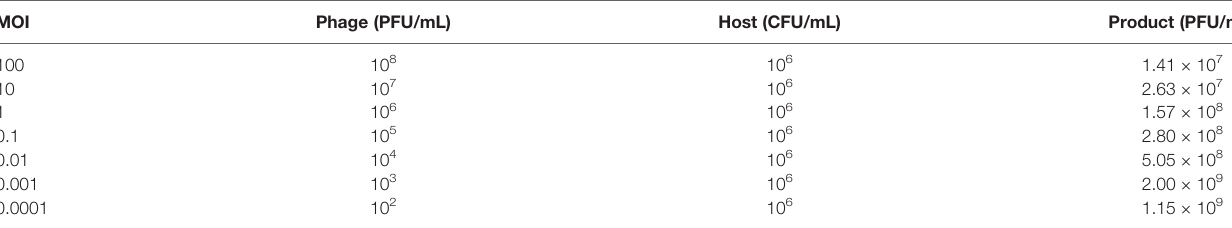
TABLE 1 | Optimal MOI for